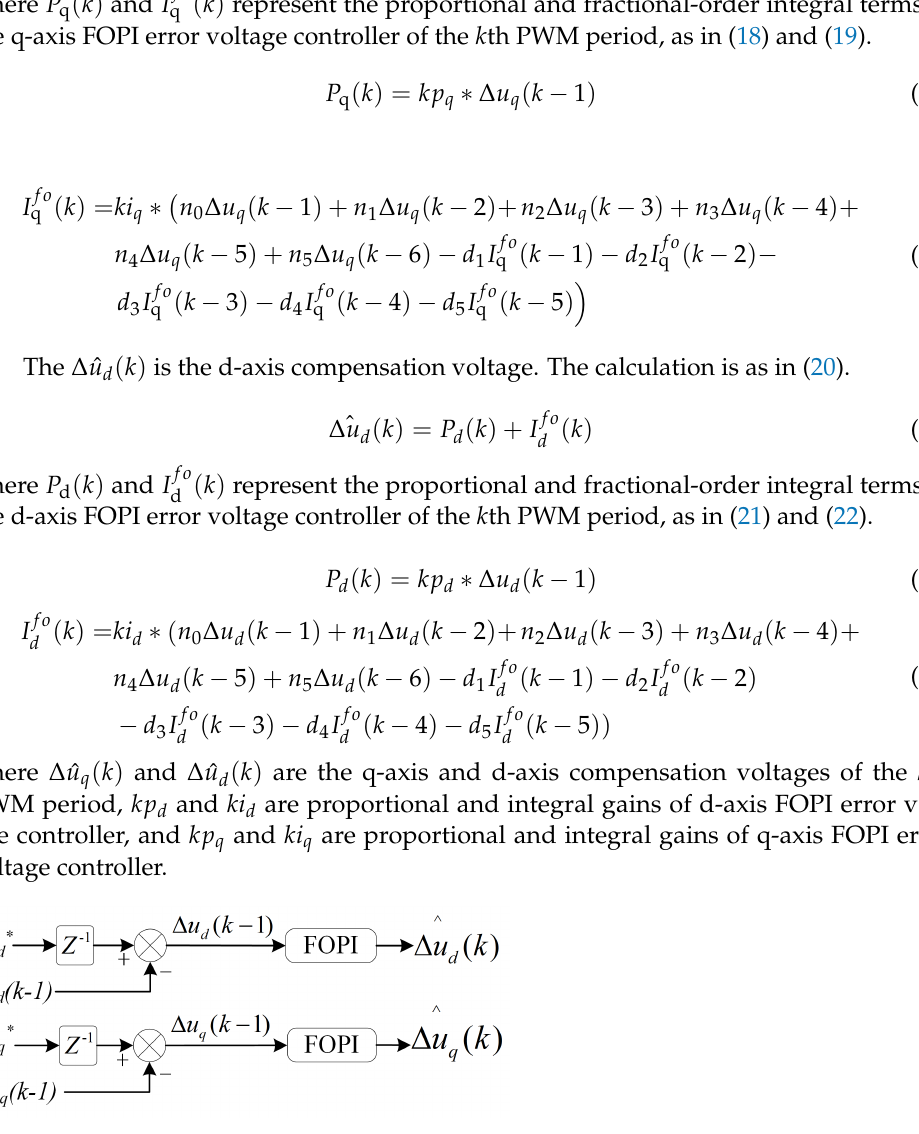
Figure 5. FOPI error voltage